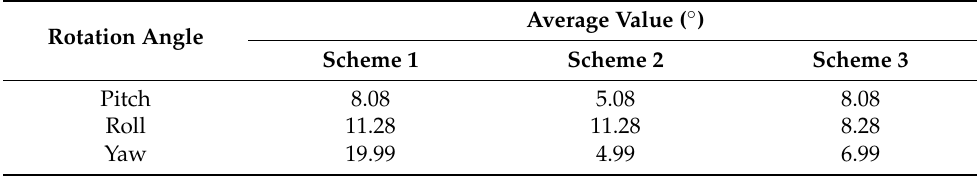
Table 3. Mean value of device